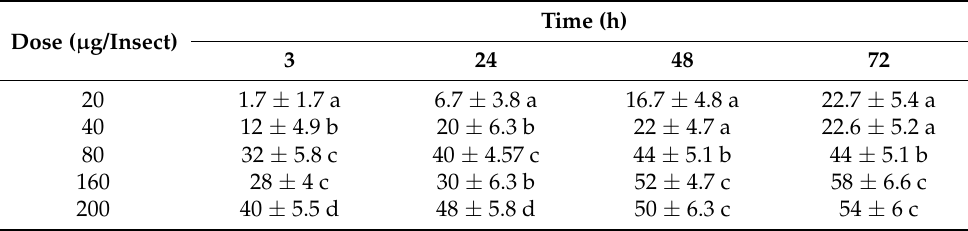
Table 3. Larvicidal activity (%) of PLF He to L. botrana recorded at 3 and 24 h after topical bioassay. Means followed by the same letter within each column are not significant different (Duncan’s multiple range tests [MRT] test p > 0.005). Time (h)